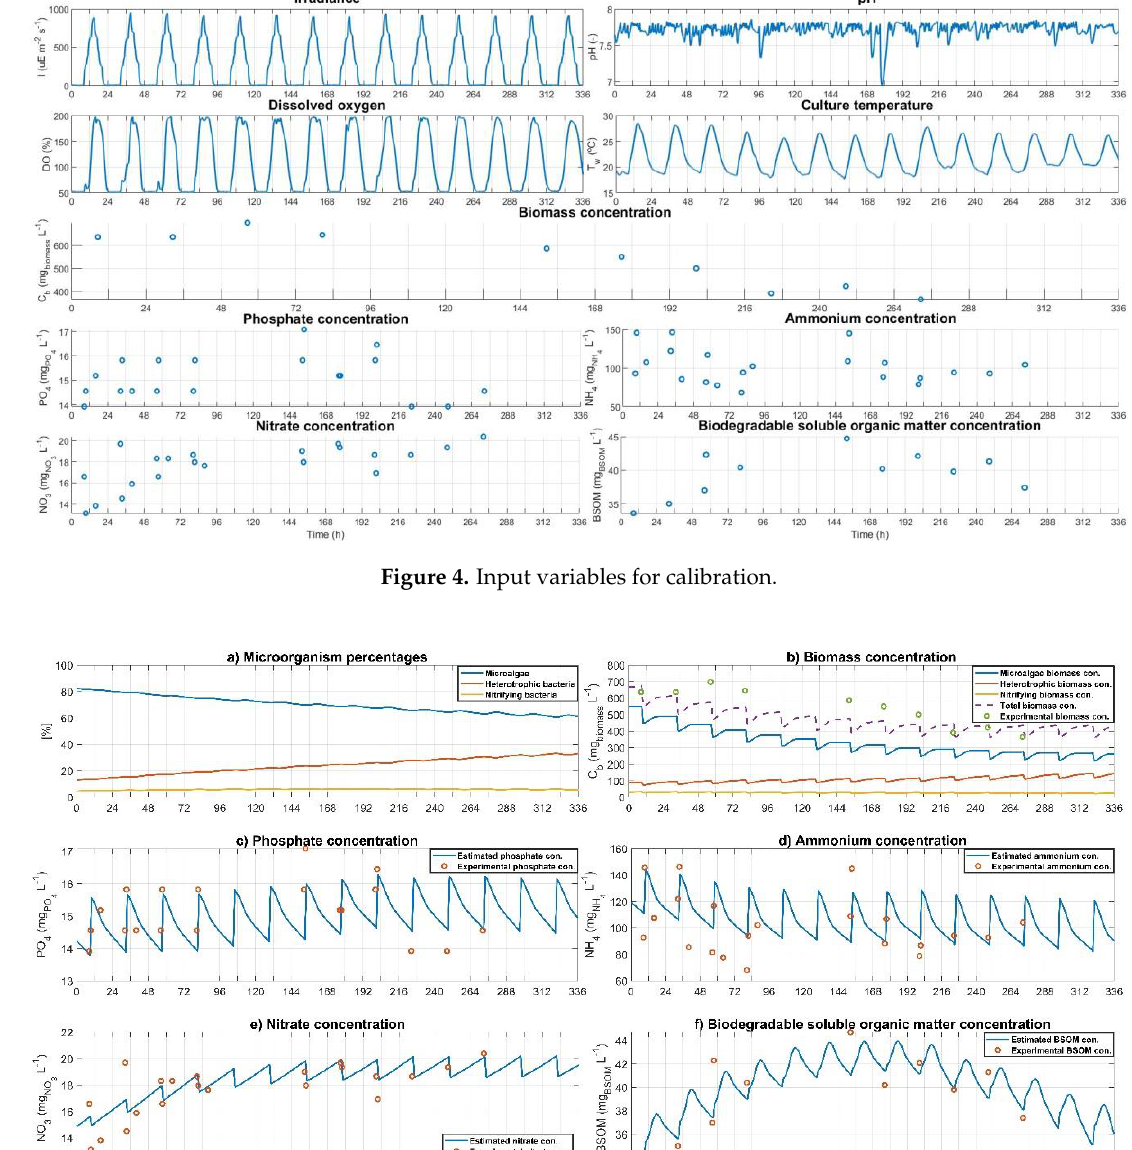
Figure 4. Input variables for calibration.